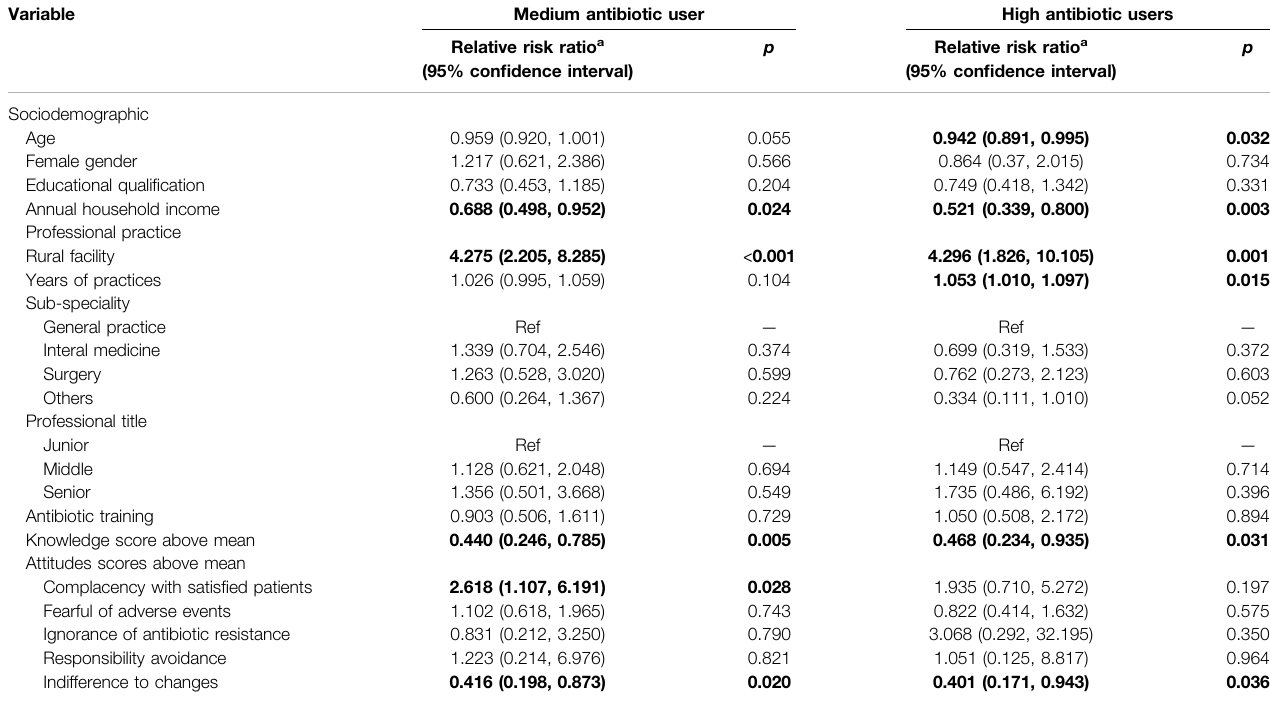
TABLE 3 | Multinomial logistic regression of physician ’ | ’ s antibiotic prescribing patterns.